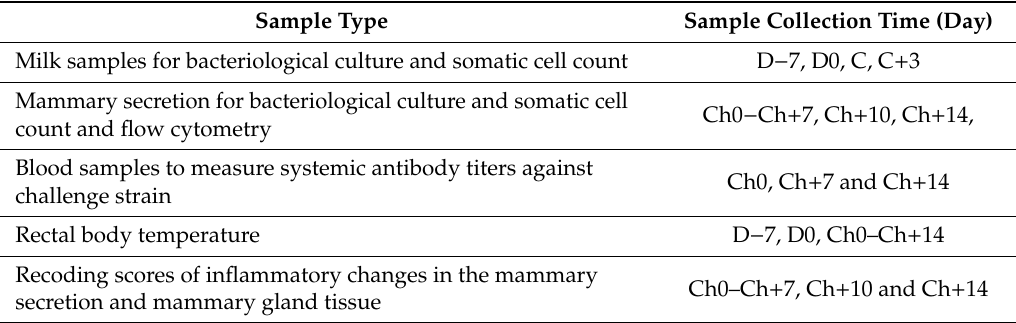
Table 3. Sample collection and data recording